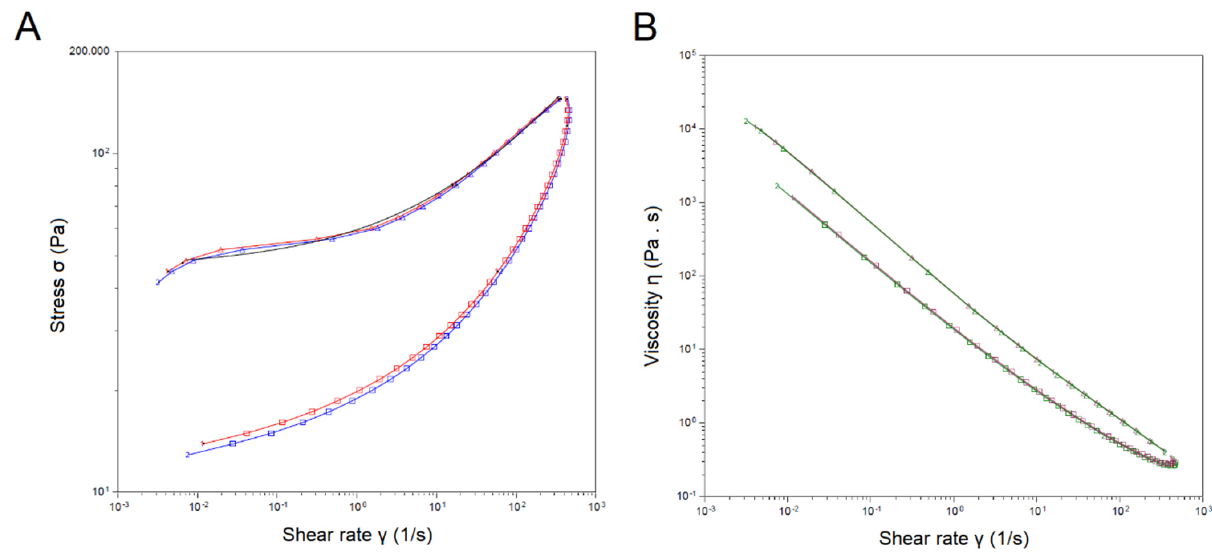
Figure 3. Rheological analysis of the developed NCTD nanoemulsion. ( A ) Flow rate as described by the stress input ( σ ; Pa) and shear rate (1/s) (red and blue lines correspond to two different batches). ( B ) Viscosity (Pa/s) as a function of shear rate (green and purple corresponding to two different batches). Calculated yield stress of 45.1 Pa, rate index of 0.345, and R 2 of 0.997.